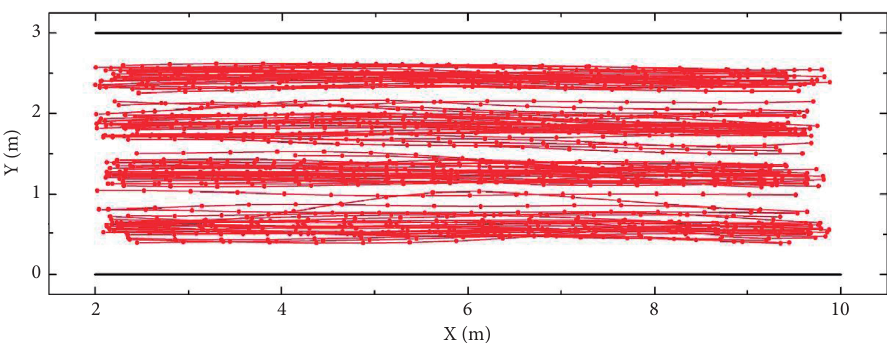
Figure 9: Predicted pedestrian trajectories formed by interpolation of discrete position